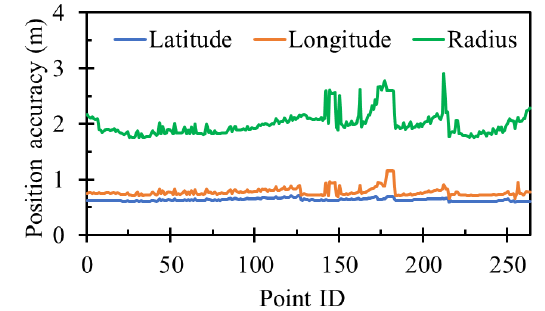
Figure 7. Geopositioning accuracy of tie points for LRO NAC images (ISIS